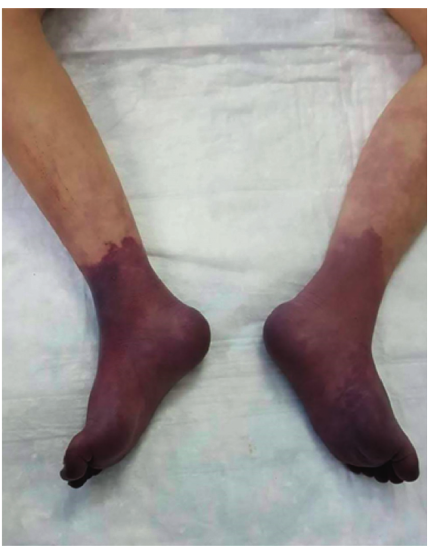
Figure 4: Gangrenous rash involves the whole feet and the lower part of the legs